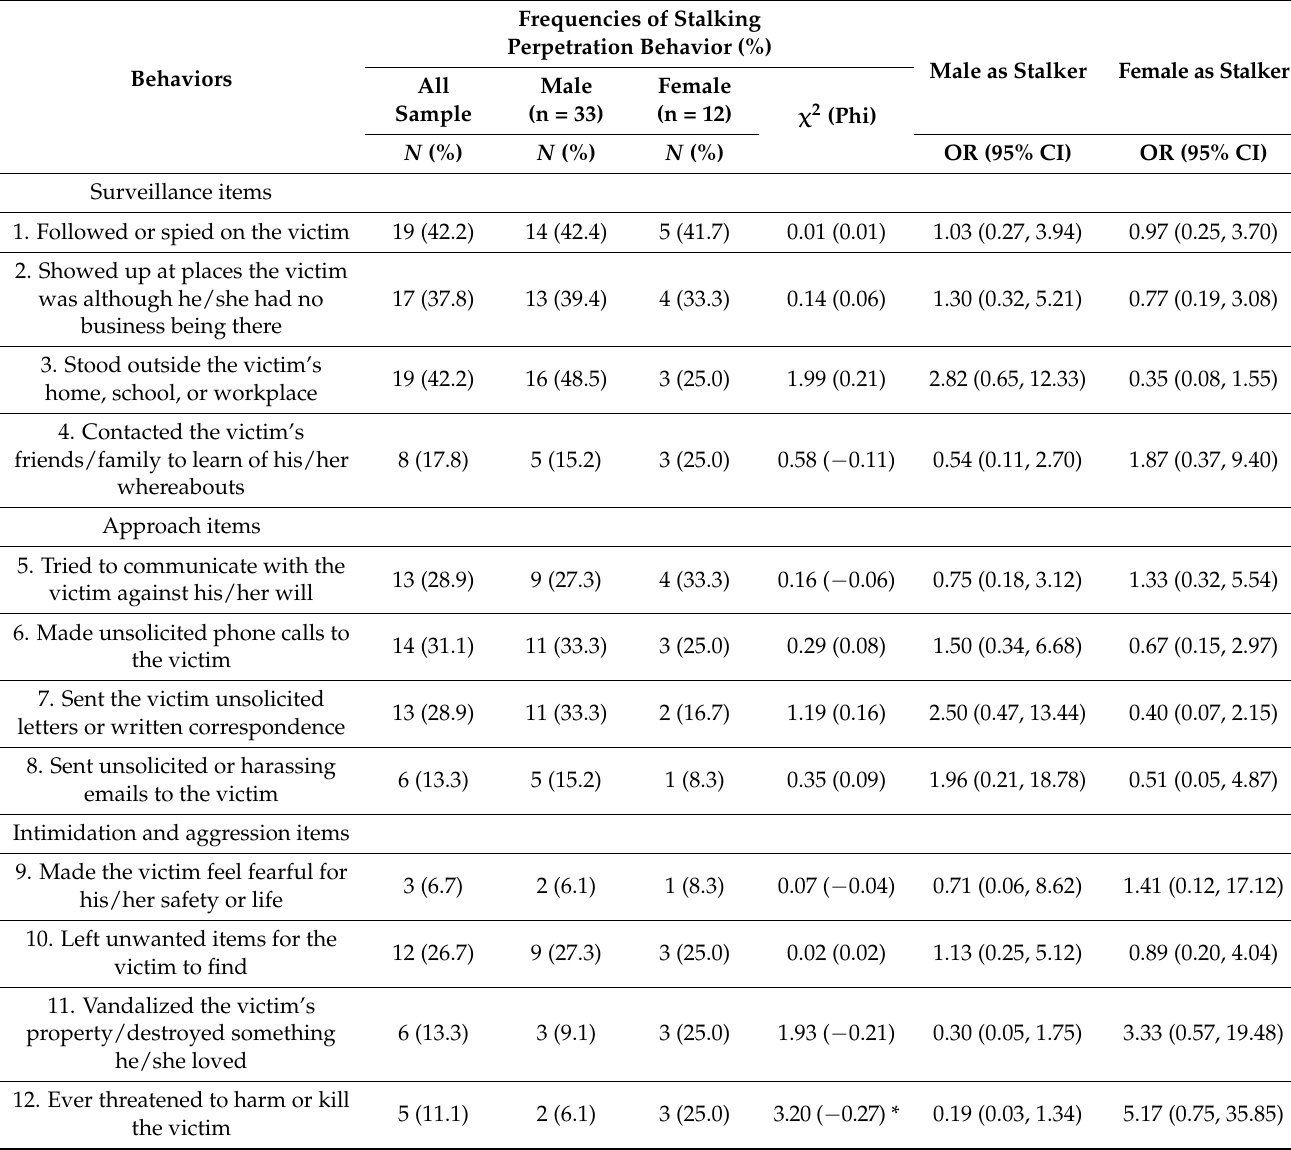
Table 2. Prevalence and unadjusted odds ratio of lifetime stalking perpetration behaviors of young adults in Hong Kong (n = 45). Behaviors